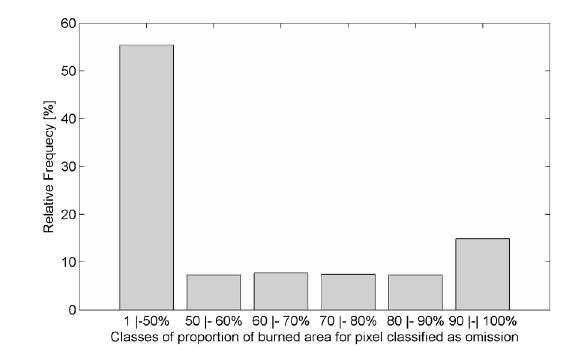
Figure 7 - Proportion of burned area for pixels characterized as omission errors.